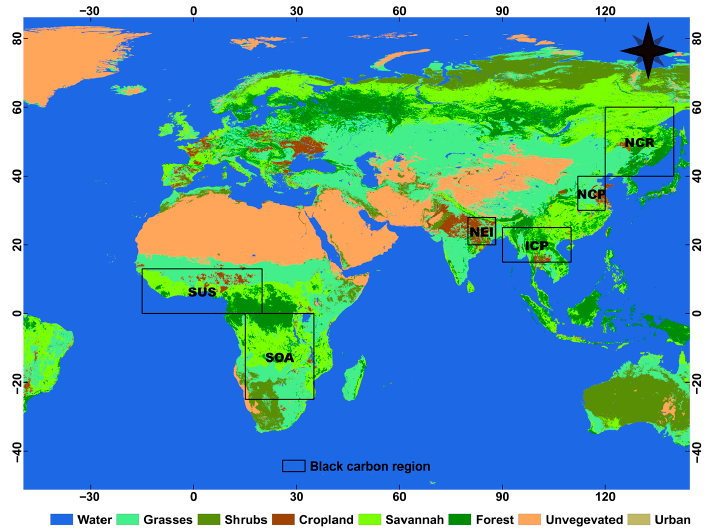
Figure 2. Regions of interest for the comparisons of monthly black carbon (BC) column concentration: Sub-Sahel (SUS), Southern Africa (SOA), Northeast India (NEI), Indo–China Peninsula (ICP), North China Plain (NCP), and Northeast China and east of Russia (NCR).